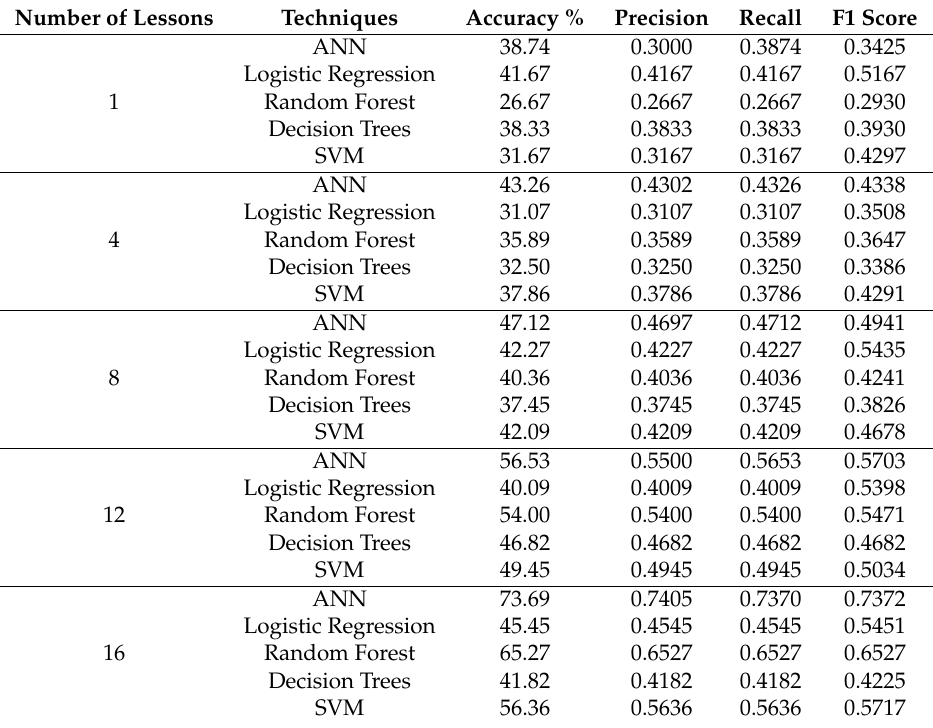
Table 4. Metric comparisons between the proposed ANN model and other state-of-the-art